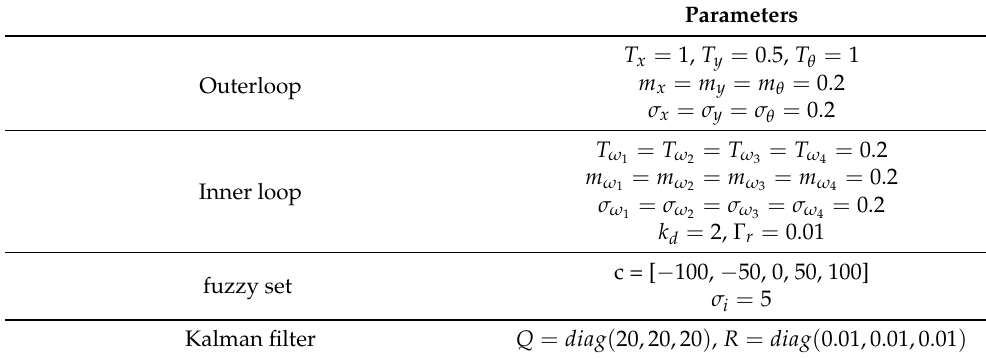
Table 3. Actual controller